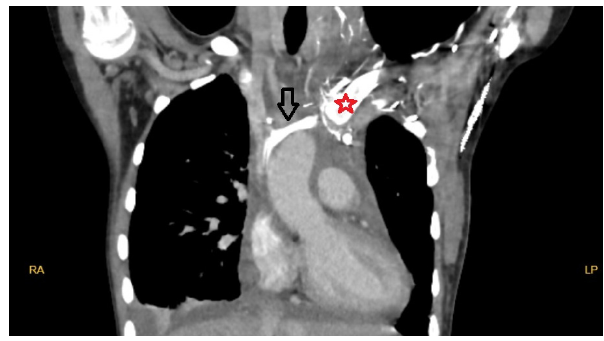
Fig. 2 - Computed tomography angiographic image of the persistent left superior vena cava. Black arrow=patent persistent left superior vena cava and anastomosis; star=proximal part of clavicula (patient has pectus carinatum deformity); LP=left posterior; RA=right